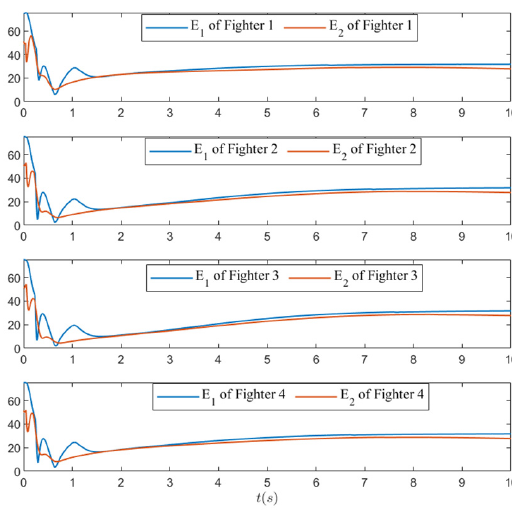
Figure 11. Control Figure 11. Control efforts.